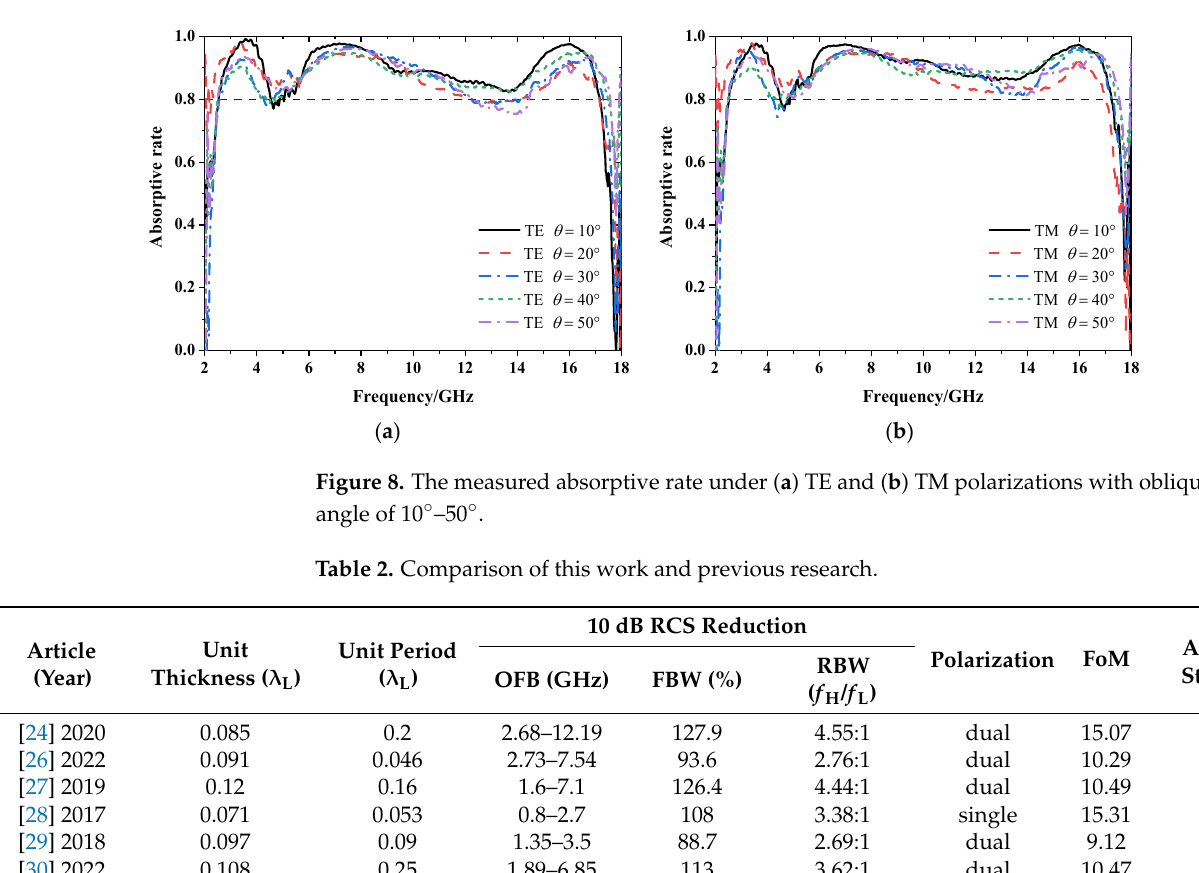
Table 2. Comparison of this work and previous research.